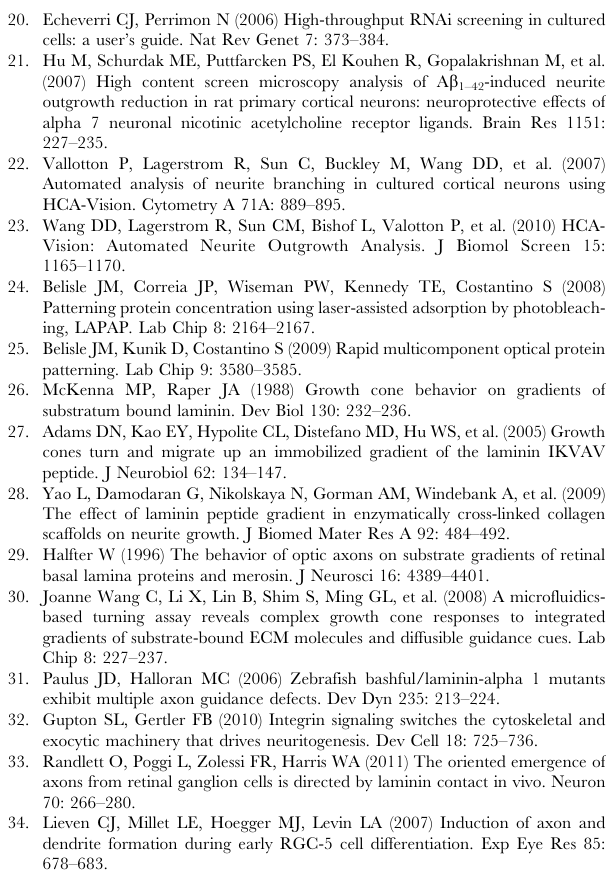
Figure S3 Histograms of the turning angle of cells imaged on low-slope and high-slope gradients at different time points before and during differentiation by staurosporine. Attracted (black, + ) and repulsed (white, 2 ) neurites were determined as described in Figure 2a. (TIF) Figure S4 Histograms of the x-position of the centroid of the cell soma along the gradient (low-slope gradient). The laminin-1 or anti-laminin (control 1) concentration was highest at 0 m m and lowest at 444 m m. (TIF) Figure S5 Histograms of the branching points of cells imaged on low-slope and high-slope gradients at different time points before and during differentiation by staurosporine. Attracted (black, + ) and repulsed (white, 2 ) neurites were determined as described in Figure 2a. (TIF) Figure S6 Histograms of the x-position of the centroid of the cell soma along the gradients (high-slope gradient). The laminin-1 or anti-laminin (control 1) concentration was highest at 0 m m and lowest at 148 m m.